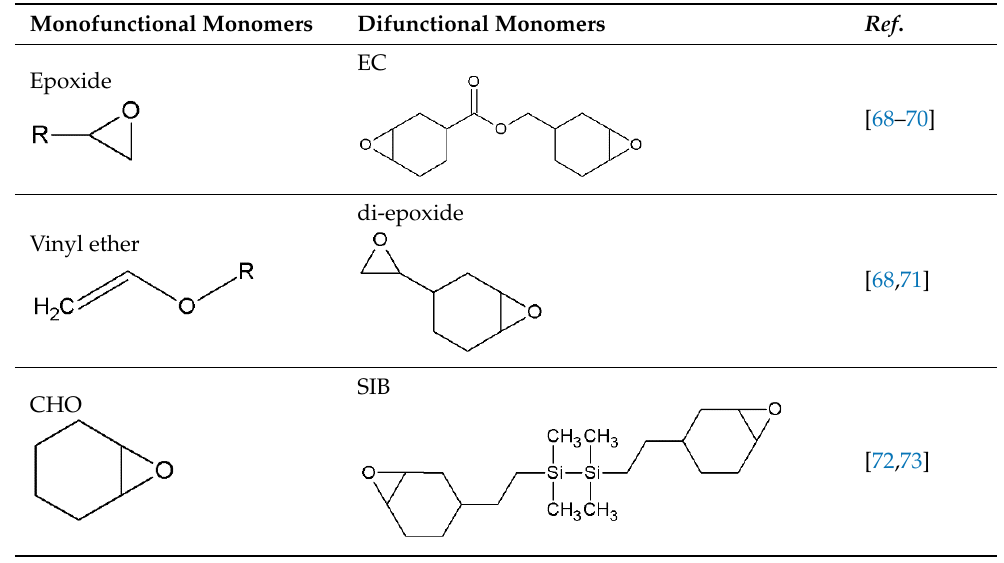
Table 1. Monomers used in cationic polymerizations.